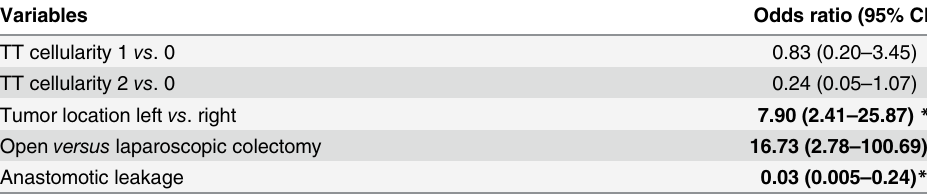
Table 4. Parameters associated with RNA quality in tumoral tissue on multivariate